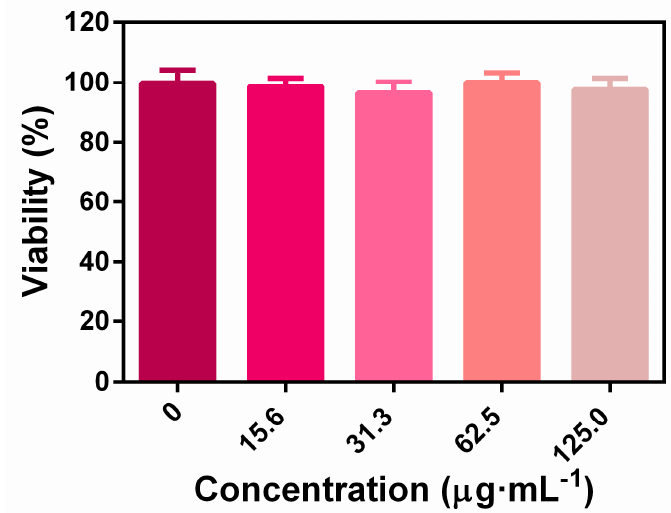
Figure A2. The 293T cell viabilities by incubating with various concentrations of ZIF-8-ICG.